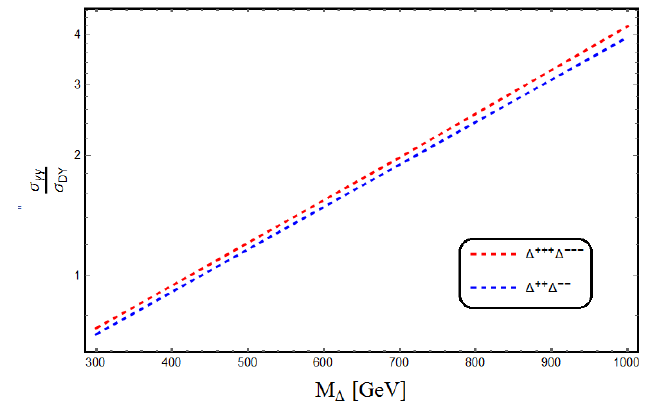
Figure 7 . The ratio between (cid:27) (cid:13)(cid:13) and leading order (cid:27) DY for triply and doubly charged Higgs pair production at the 13 TeV